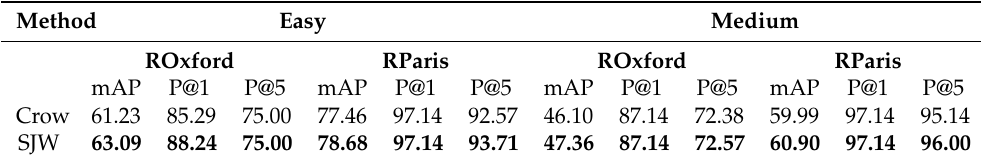
Table 4. Performance (mAP) comparison between cross-dimensional weighting (Crow) [26] and saliency joint weighting (SJW) on the ROxford and RParis data sets. The best result is highlighted in